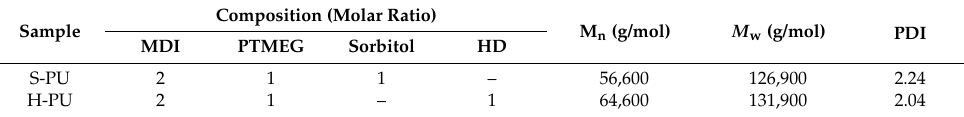
Table 1. Composition and molecular weights of the prepared PUs.